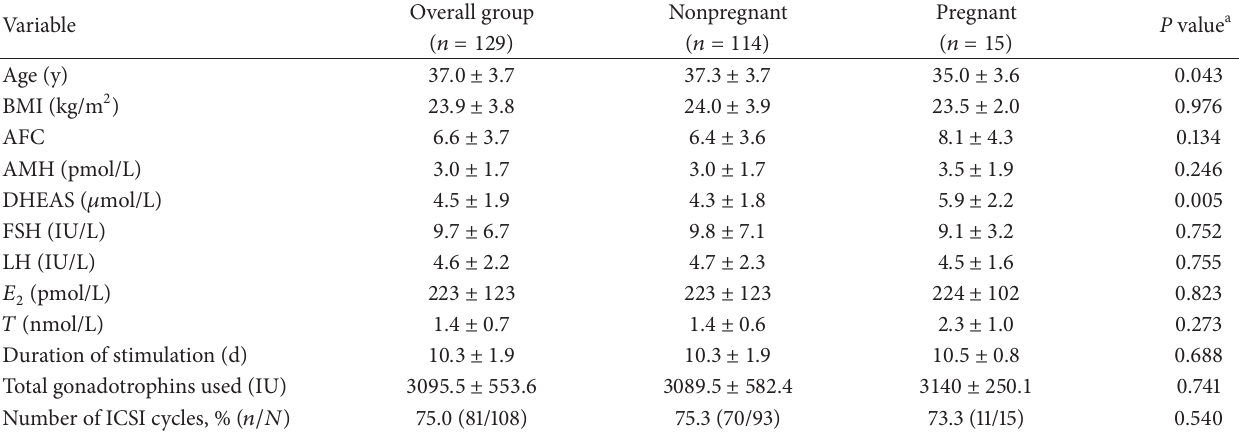
Table 1: Baseline patient and treatment characteristics of studied IVF cycles resulting in clinical pregnancy and nonpregnancy.